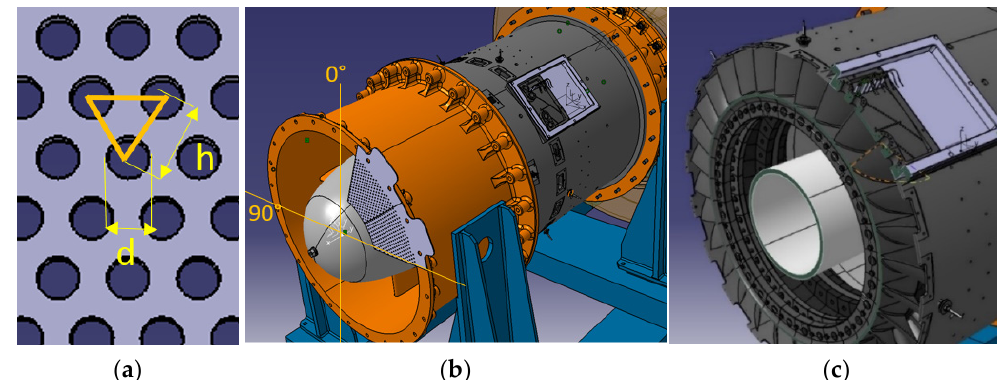
Figure 1. ( a ) CAD representation of the equilateral triangular pattern of the grid holes; ( b,c ) CAD representation of the CME2 compressor showing grid position with respect to instrumented window.